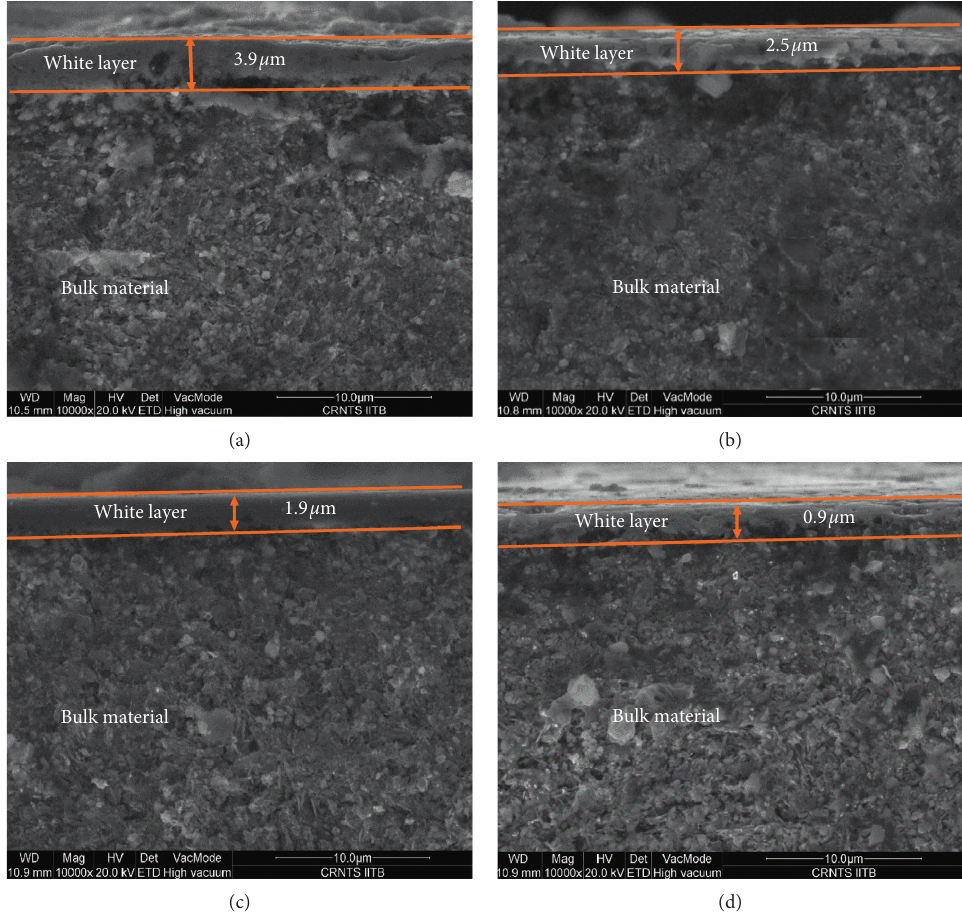
Figure 11: SEM images of white layer for different near-dry machining environments at cutting speed, 200m/min and feed, 0.2 mm/rev. (a) Dry environment; (b) CCAVT environment; (c) MQCL environment; (d) Hybrid NF-MQCL